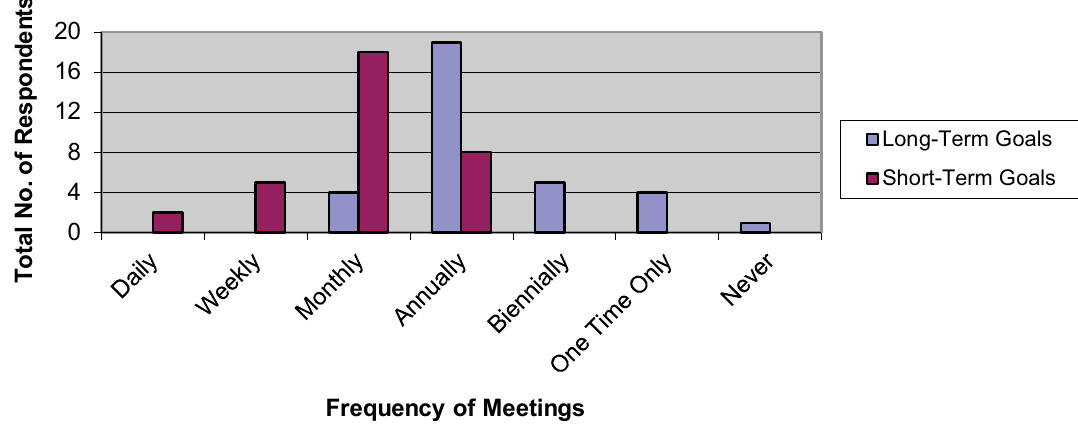
Figure 9. Reported frequency of goal-setting meetings in reintroductions.